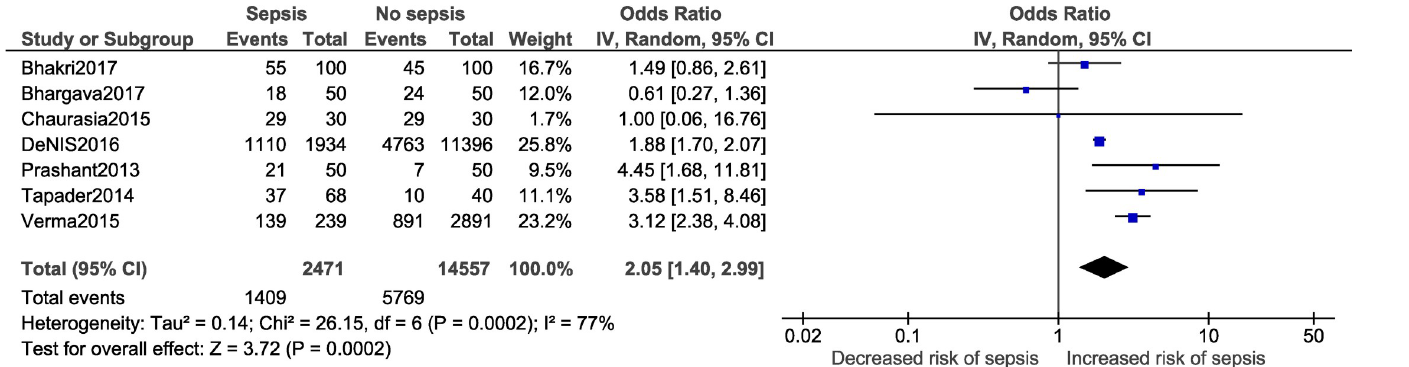
PLOS ONE | https://doi.org/10.1371/journal.pone.0215683 April 25, 2019 10 /